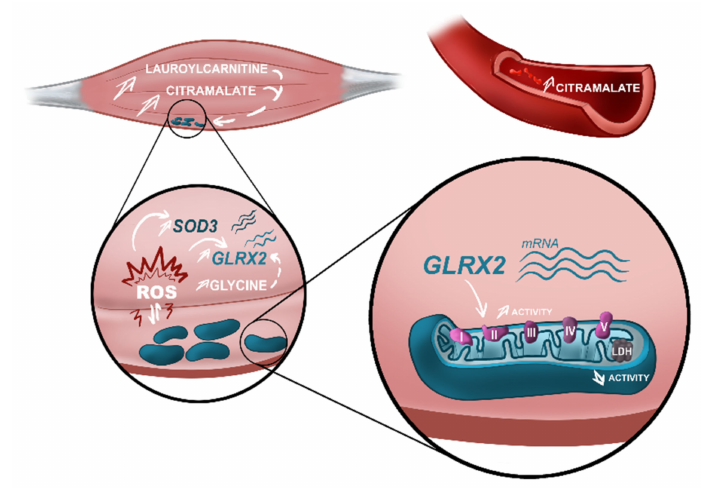
Figure 4. Alterations in actors of the energetic metabolism found in early-stage ALS patients. Metabolomics analysis performed in muscle and serum of ALS patients identified different metabolomes characterized by an increase in citramalate in both matrices. Besides this, increased levels of lauroylcarnitine were identified in the muscle of ALS patients as a bad prognostic factor. High levels of citramalate and lauroylcarnitine are associated with mitochondrial impairment. In ALS muscle, we observed a discrete accumulation of mitochondria in the subsarcolemnic space, suggestive of mitochondrial dysfunction. Mitochondrial dysfunction is a well-known source of reactive oxygen species (ROS). Transcriptomics analysis of muscle showed upregulation in ALS samples of two genes, SOD3 and GLRX2, that participate in the cellular antioxidant response. Furthermore, high levels of glycine—also found in the muscle of ALS patients—are associated with an